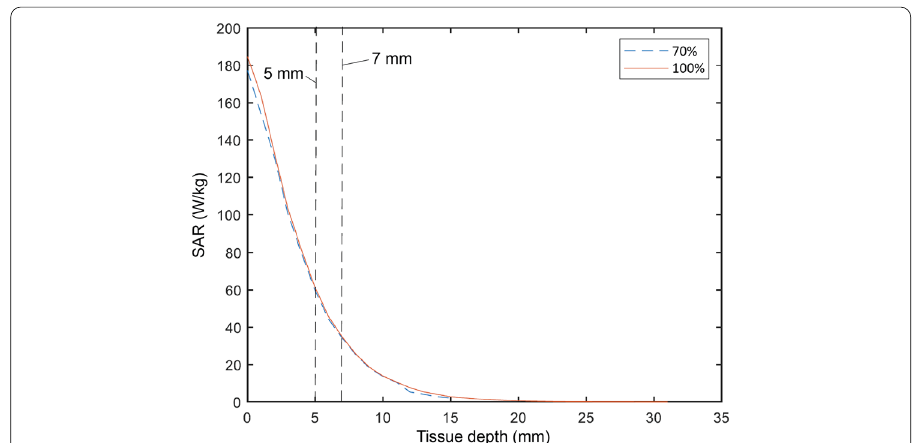
Fig. 9 Simulated SAR plotted as a function of the tissue depth